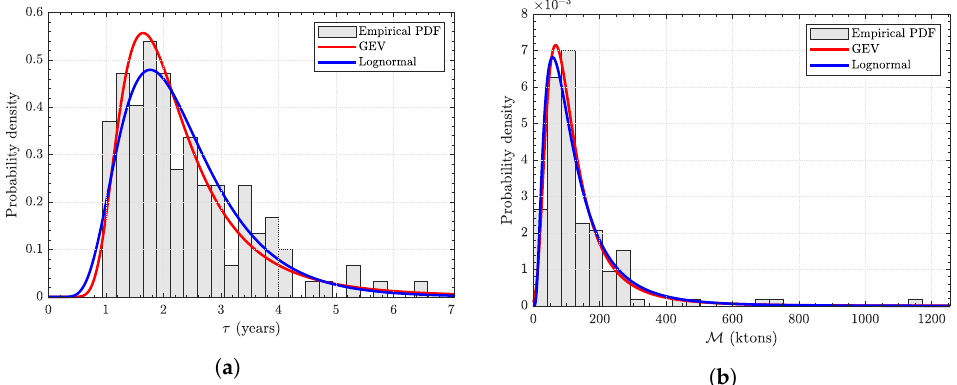
Figure 9. Distribution of fitting parameters for physical scaling: ( a ) τ , GEV mean = 2.37 years and ( b ) M , GEV mean = 106.37 ktons.